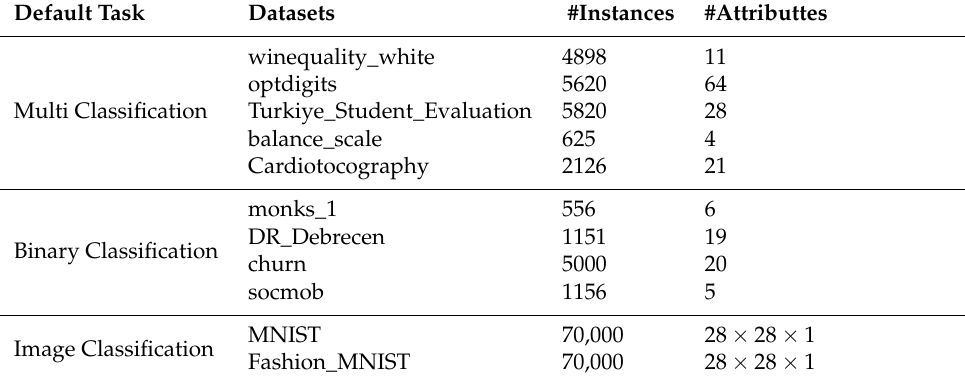
Table 1. Details of